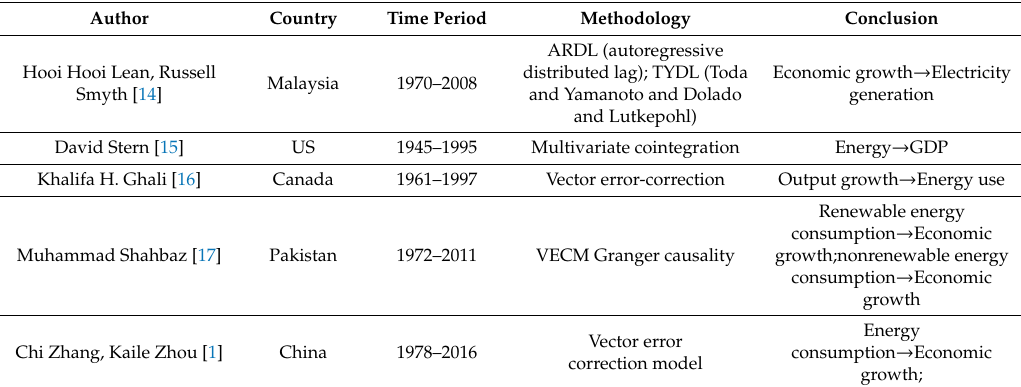
Table 1. Single country case for Granger causality